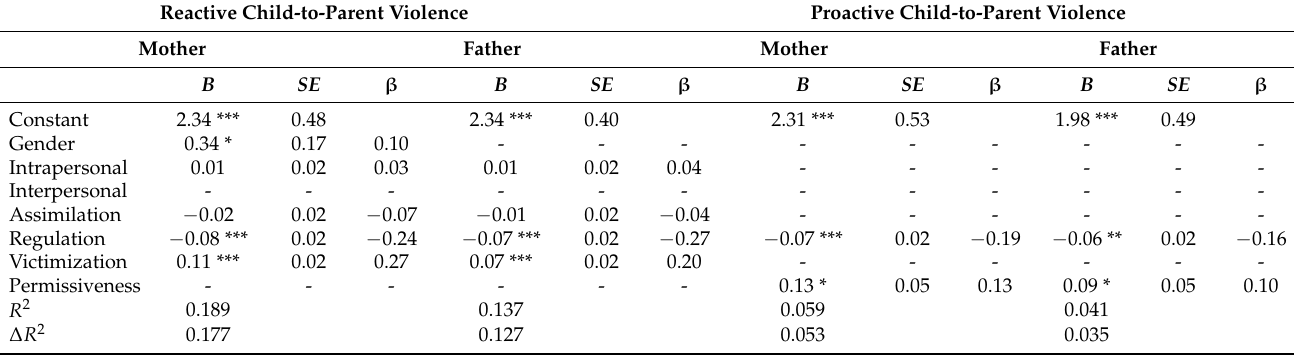
Table 4. Multiple linear regressions of the prediction of reactive and proactive child-to-parent violence by specialist